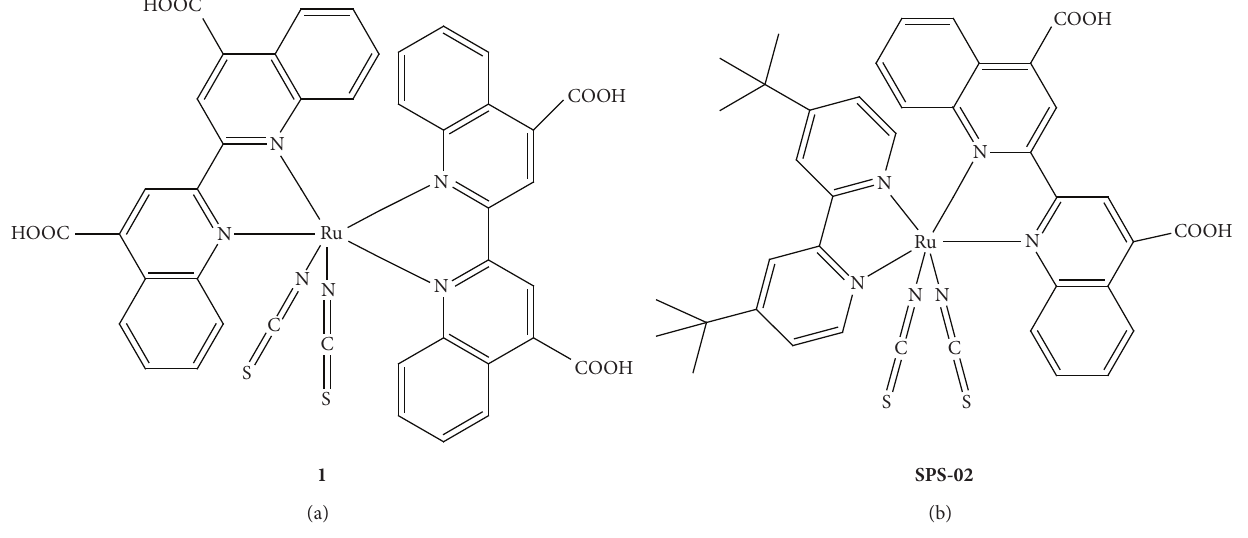
F 1: Chemical structures of 1 and SPS-02